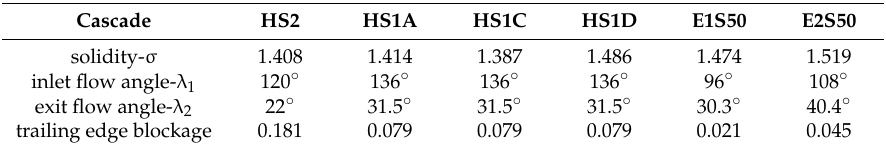
Table 1. Design data of six transonic cascades tested at Carleton University [23–25].